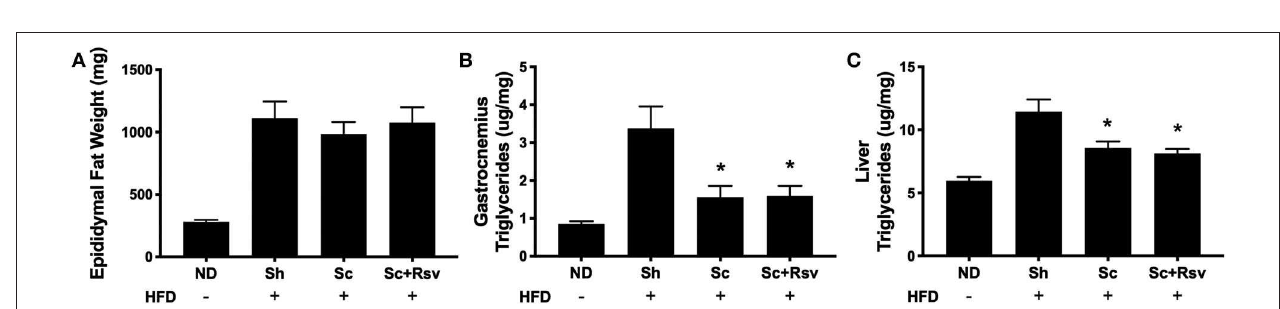
FIGURE 4 | The effect of scaffolds on epididymal fat pad weight and triglyceride accumulation in the muscle and liver. Epididymal fat pad weight (A) and triglyceride content in the gastrocnemius muscle (B) and liver (C) . Statistics were calculated by one-way ANOVA with a Tukey’s multiple comparisons test. * Represents p < 0.05 compared to HFD + Sh. n = 4-5 mice per